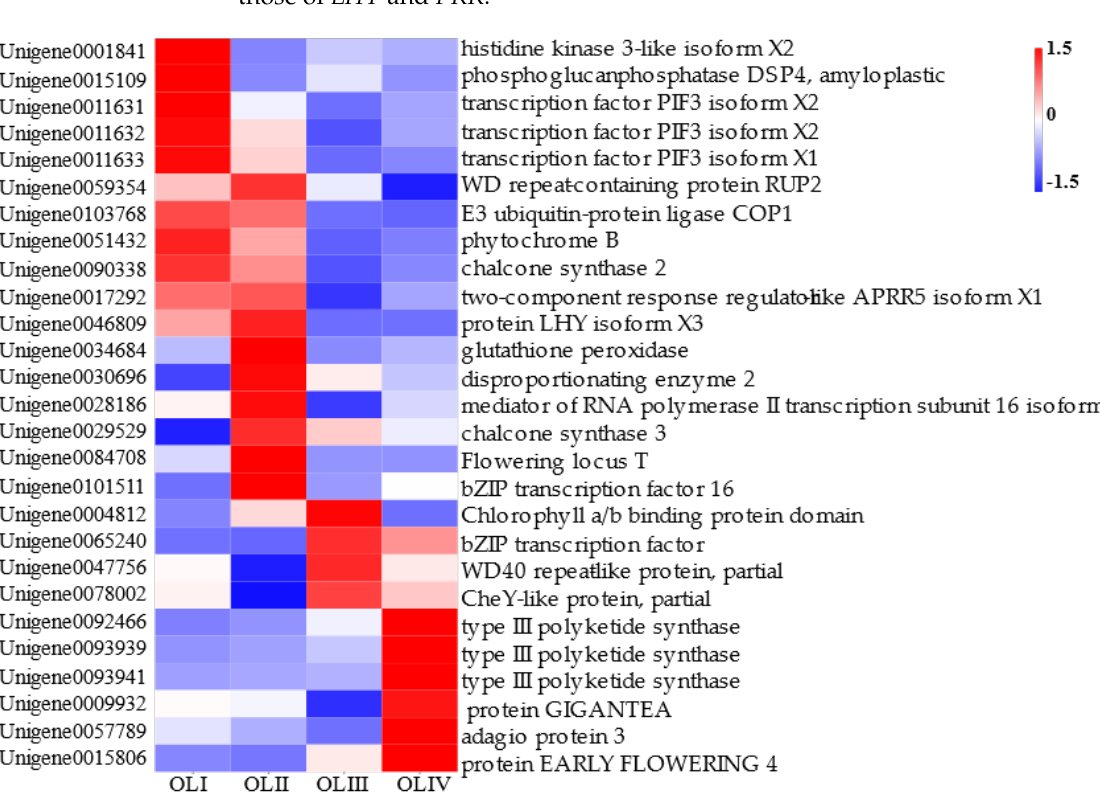
Figure 8. The heatmap showed the DEGs related to